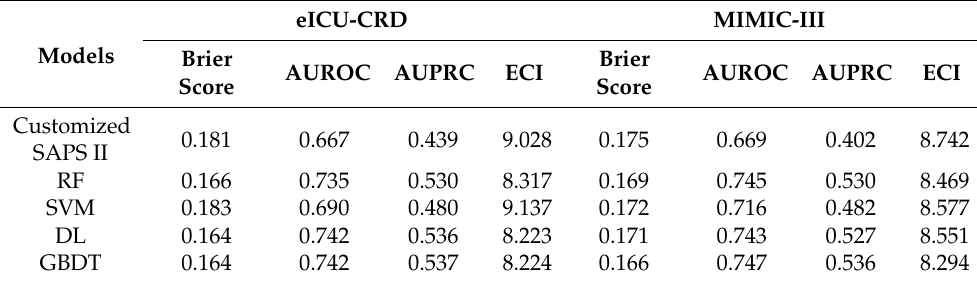
Table 4. Prediction performance of the five models on eICU-CRD (internal) and MIMIC-III (external).